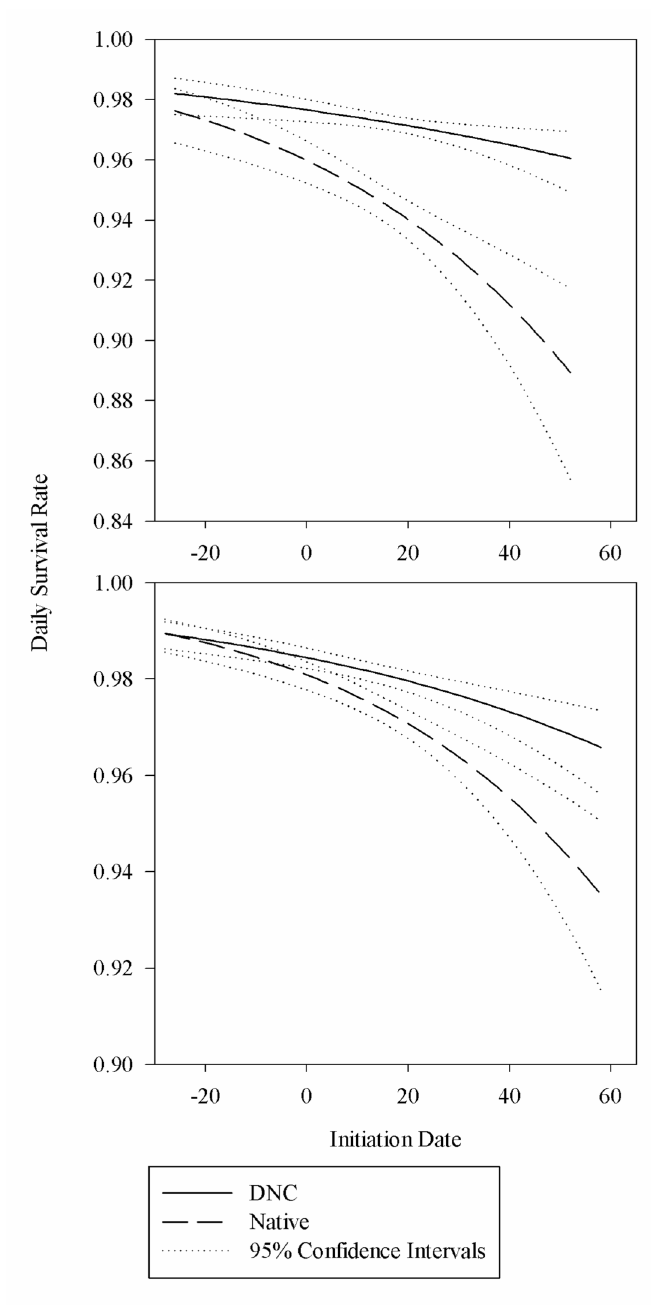
Figure 3. Effect of nest initiation date on daily survival rate of nests. Estimated daily survival rate in relation to nest initiation date for nests in multi-species native plantings and dense nesting cover (DNC) in 2010 (below) and 2011 (above) in the Devils Lake Wetland Management District, North Dakota.